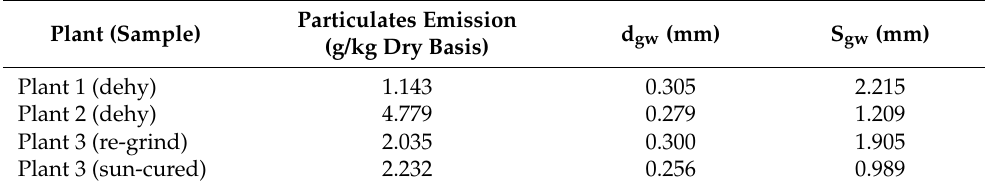
Table 3. Particulates emission from hammer mill cyclone stacks and particle size distribution of alfalfa grinds (geometric mean diameter d gw and geometric standard deviation S gw ) sampled at the same time as the assessment of particulates emission levels in three dehy plants in Alberta (data taken from Chawla et al. [3]).